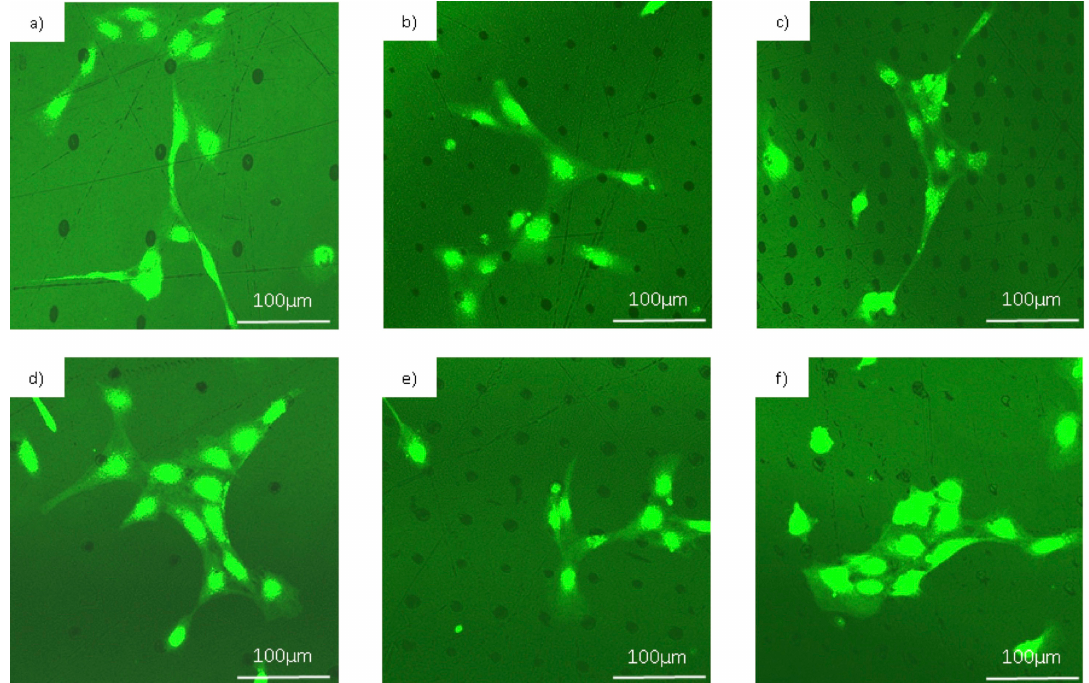
Figure 10. Fluorescence microscopy images of the endothelial cells over the different patterns after 17 h culture. ( a – c ) show the endothelial cell attachment to the holes fabricated on titanium with period 90, 45, and 30 μ m, respectively; ( d – f ) show the cells on structured tantalum with pitch 90, 45, and 30 μ m, respectively.